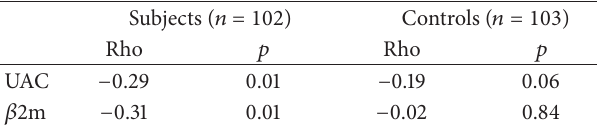
Table 5: Comparison of correlation of 𝛽 2m with eGFR versus UAC with eGFR in subjects and controls.